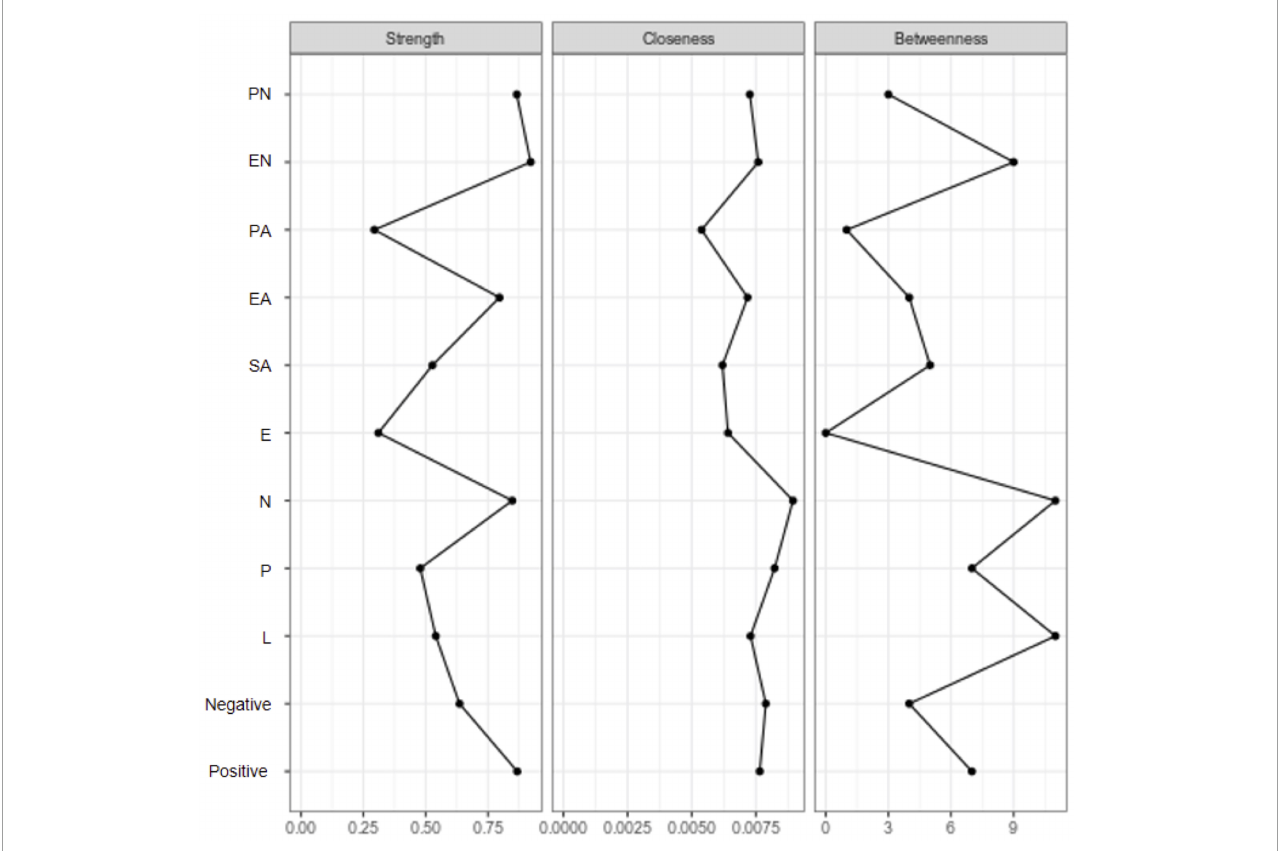
FIGURE3 Centrality measures among healthy control group (EN, emotional neglect; EA, emotional abuse; PN, physical neglect; PA, physical abuse; SA, sex abuse; N, neuroticism; E, extraversion; P, psychoticism; L, lie scale; Positive, positive coping; Negative, negative